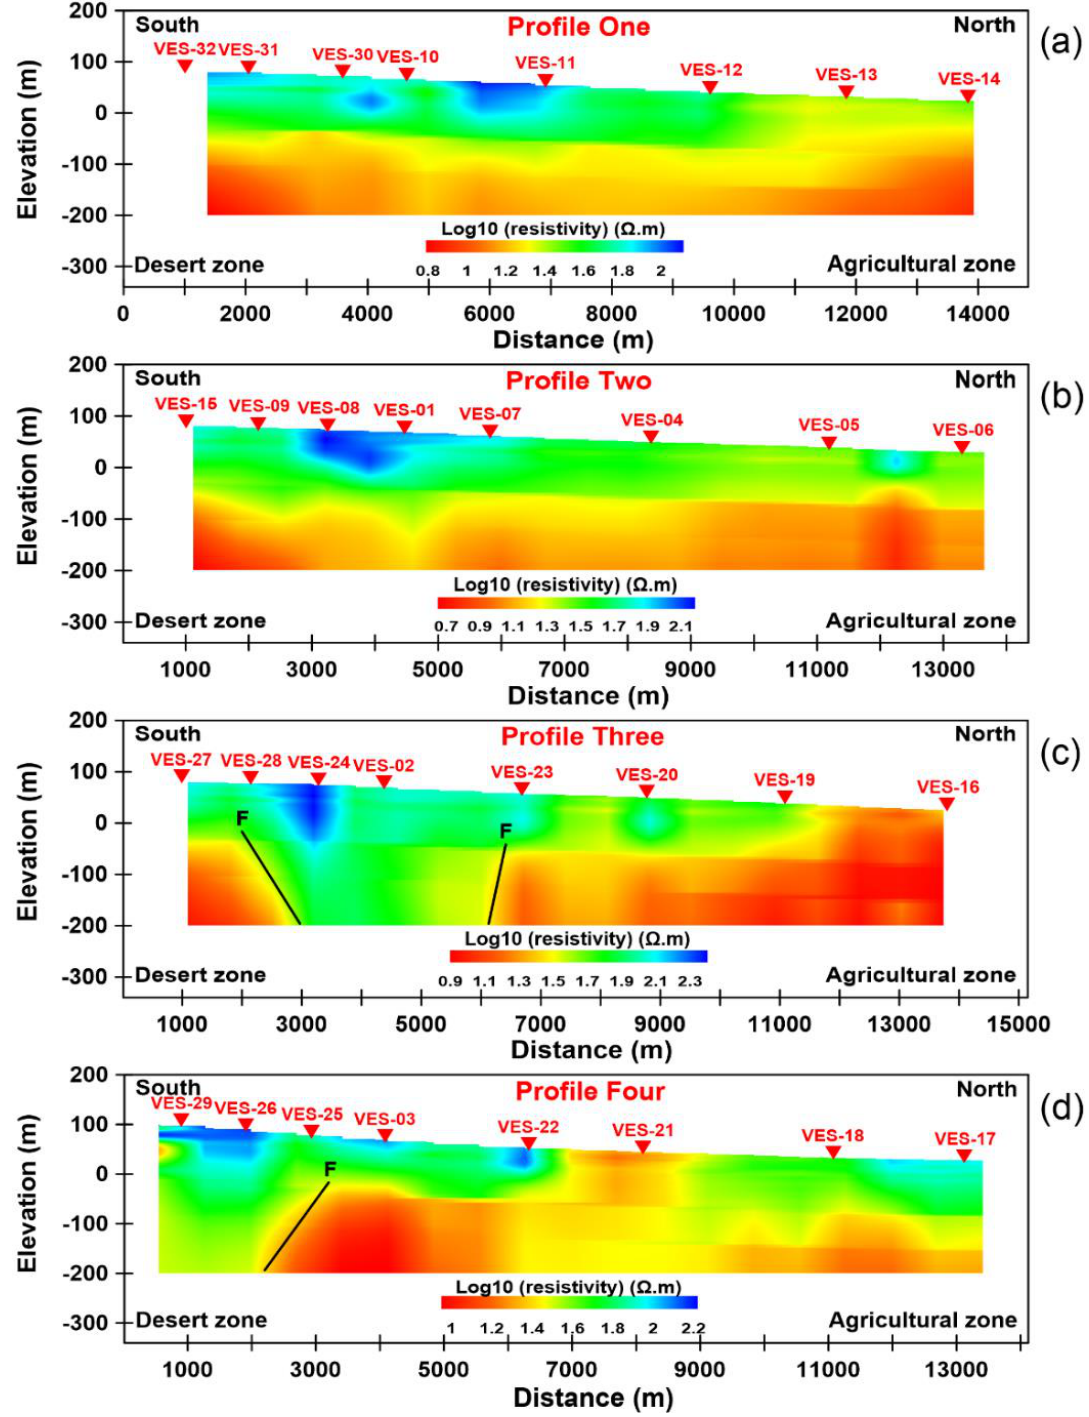
Figure 11. Two-dimensional (2D) inversion models of VES sites along four main profiles. The “F” symbol indicates the fault. ( a ) Profile One; ( b ) Profile Two; ( c ) Profile Three; ( d ) Profile Four.